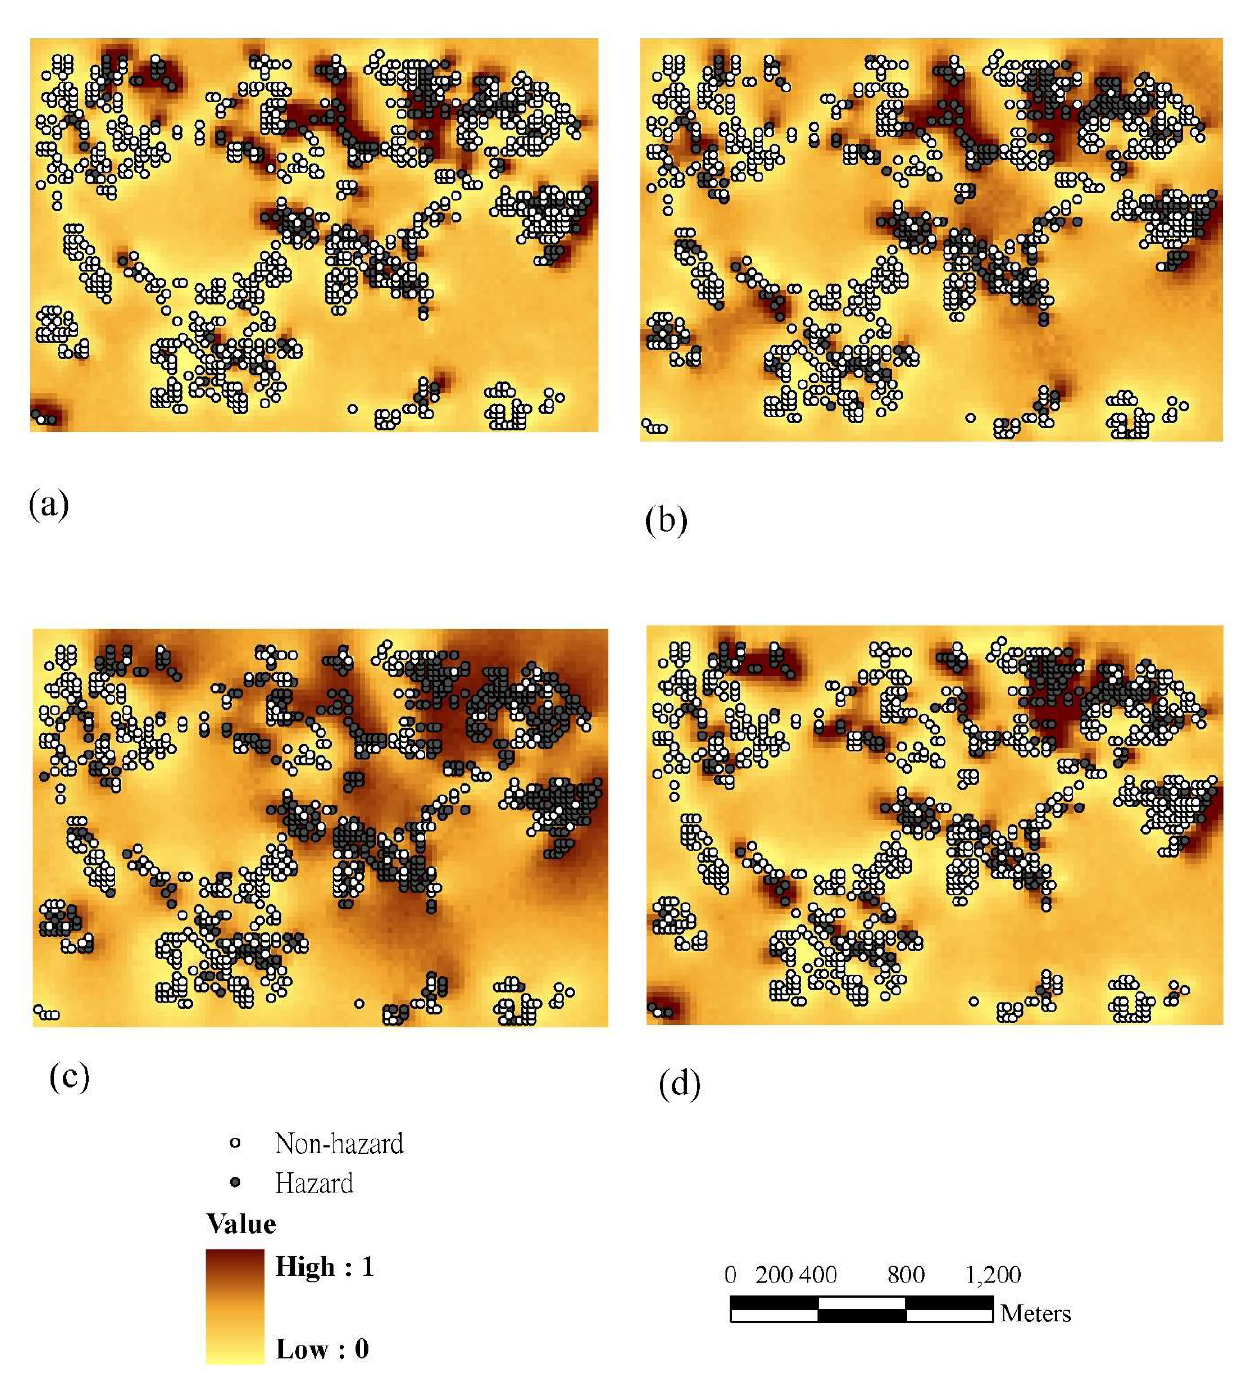
Figure 4. The probability maps of (a) Cr (b) Cu (c) Ni (d) Zn in 1000 realizations using sequential indicator simulation based on 1,082